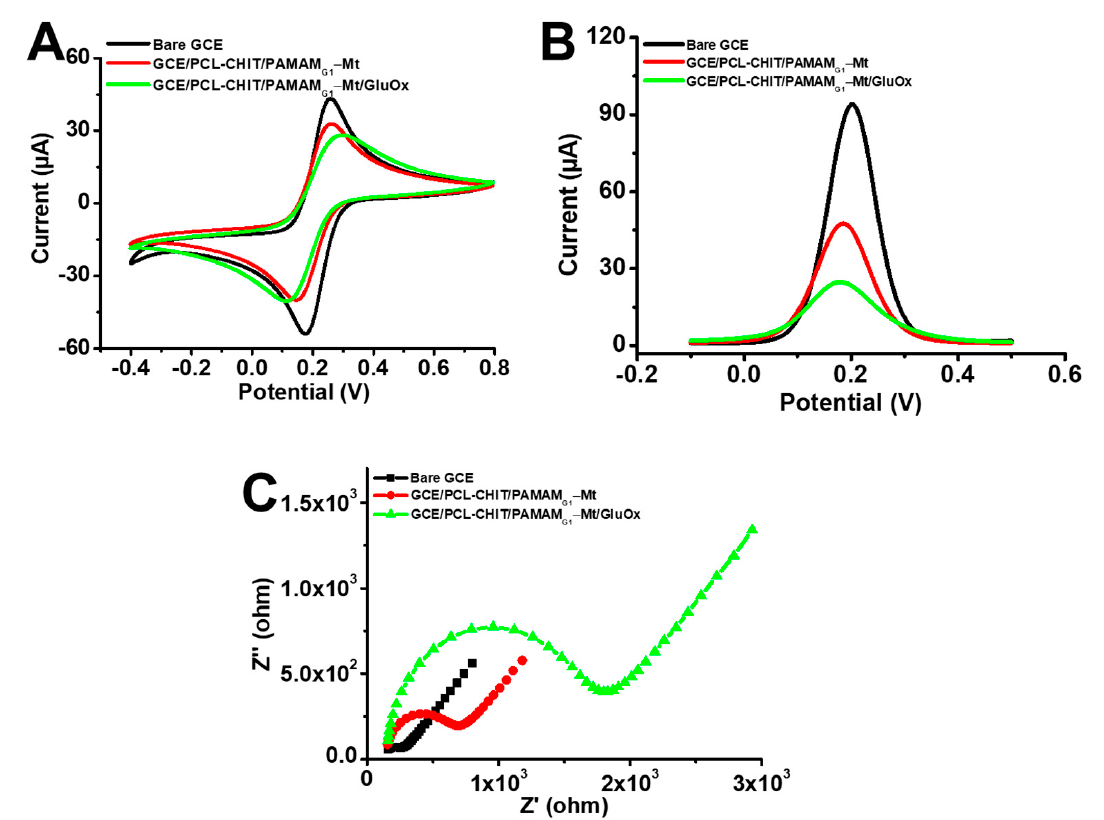
Figure 5. ( A ) Cyclic voltammograms of bare GCE, GCE/PCL–CHIT/PAMAM G1 –Mt, and GCE/PCL–CHIT/PAMAM G1 –Mt/GluO x at a scan rate of 50 mV.s − 1 . ( B ) Differential pulse voltammograms of bare GCE, GCE/PCL–CHIT/PAMAM G1 –Mt, and GCE/PCL–CHIT/PAMAM G1 –Mt/GluO x at a scan rate of 25 mV.s − 1 . ( C ) Nyquist plots for EIS of bare GCE, GCE/PCL–CHIT/PAMAM G1 –Mt, and GCE/PCL–CHIT/PAMAM G1 –Mt/GluO x at +0.18 V (all measurement cells included 5.0 mM K 3 [Fe(CN) 6 ] and 0.1 M KCl in a pH 6.5, 50 mM phosphate buffer).